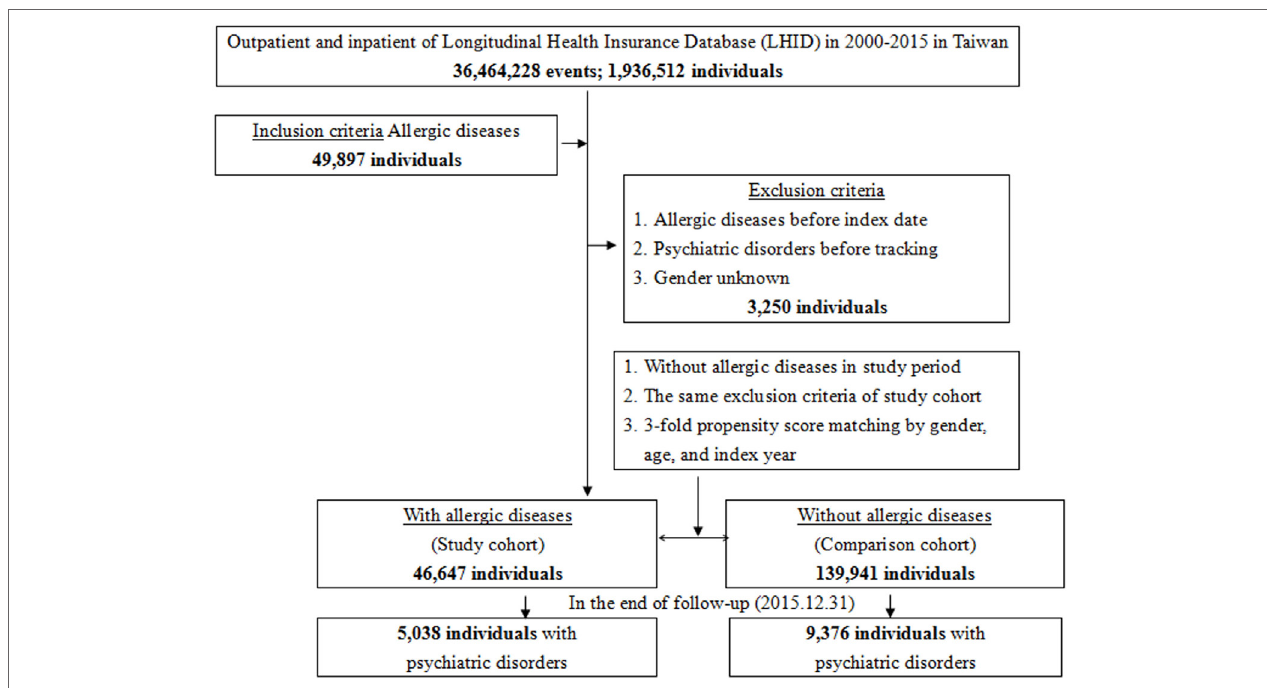
FigUre 1 | Flowchart of the study sample selection from the National Health Insurance Research Database in